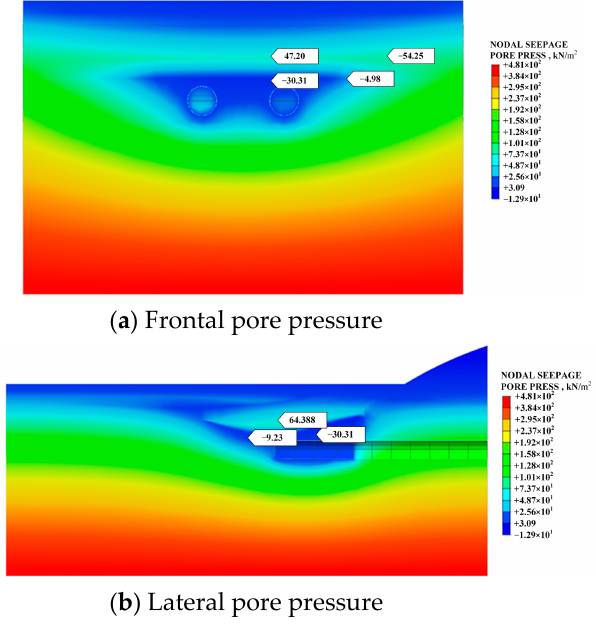
Figure 17. Negative pressure zone.